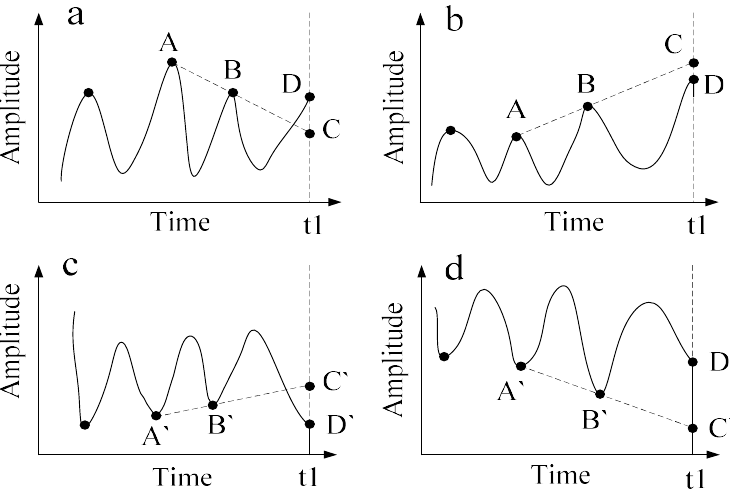
Figure 1. The legend for the local linear extrapolation method. ( a ) The endpoint D is greater than the intersection C; ( b ) The endpoint D is lower than the intersection C; ( c ) The endpoint D’ is lower than the intersection C’; ( d ) The endpoint D’ is greater than the intersection C’.